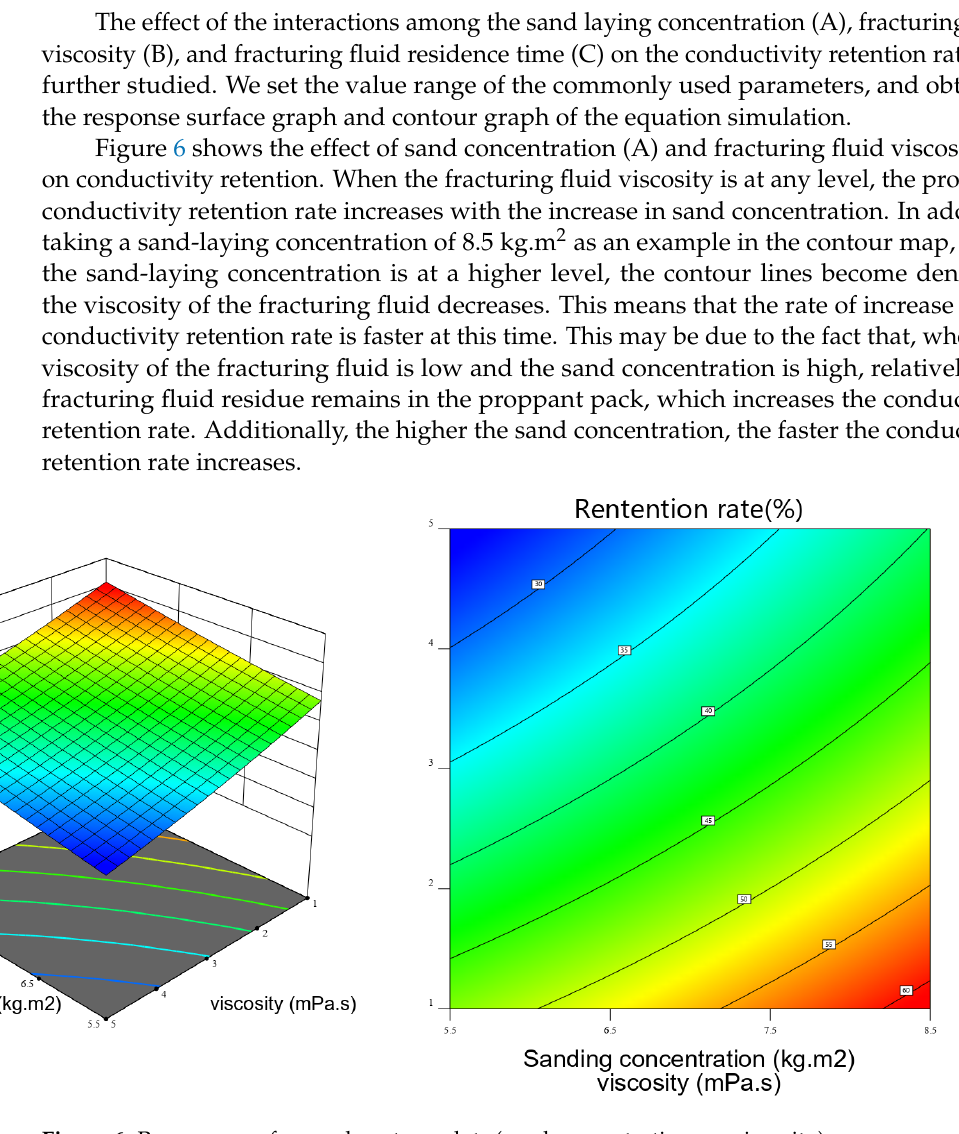
Figure 6. Response surface and contour plots (sand concentration vs. viscosity).